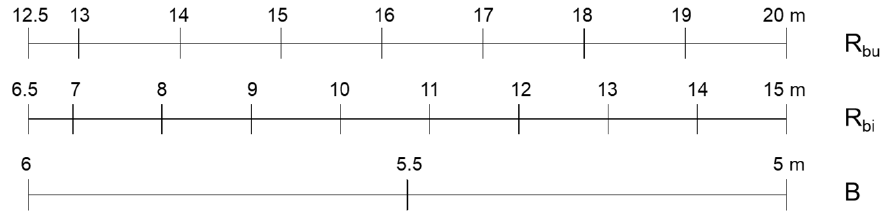
Figure 4. Circulatory roadway cross slope according to [5]: ( a ) recommended cross slope direction and ( b ) circulatory roadway in one plane. Slope direction is represented by the arrows.